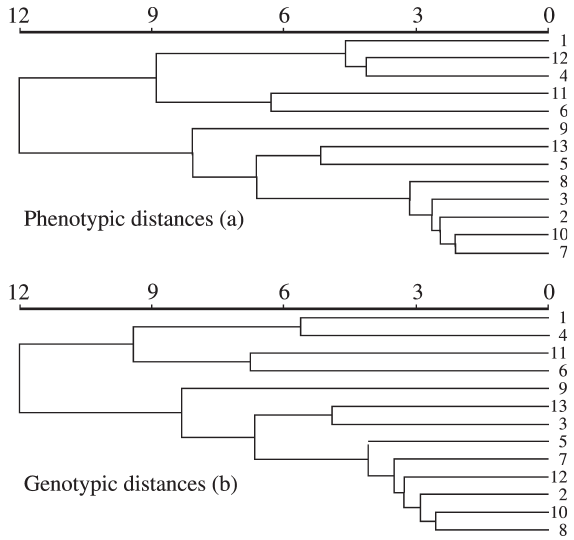
Figure1 -Patternofphenotypic(a)andgenotypic(b)variationamongthe Eugenia dysenterica DC populations defined by the UPGMA clustering. The significance was detected by cophenetic correlations (5000 permuta- tions) with r = 0.6874** for the phenotypic distances and r = 0.6100** for the genotypic distances.